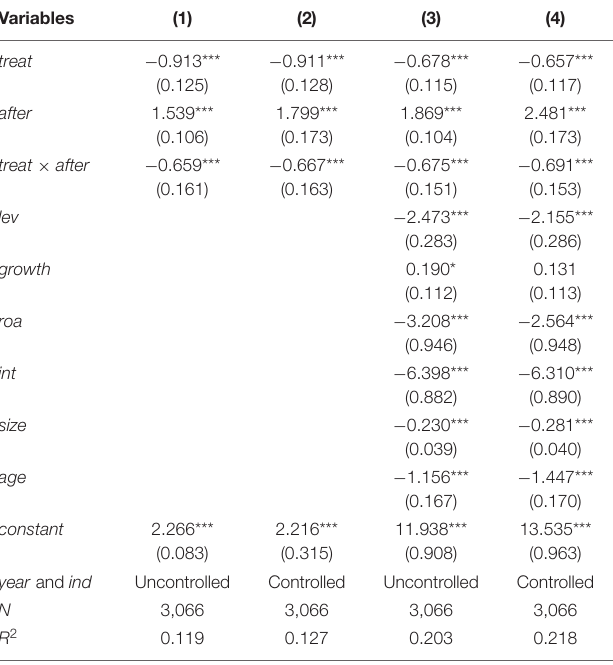
The numbers in parentheses are the standard errors. The superscripted symbols ** and *** represent significant levels of 5 and 1%, respectively. The R 2 values represent adjusted R 2 values when mixed regression was